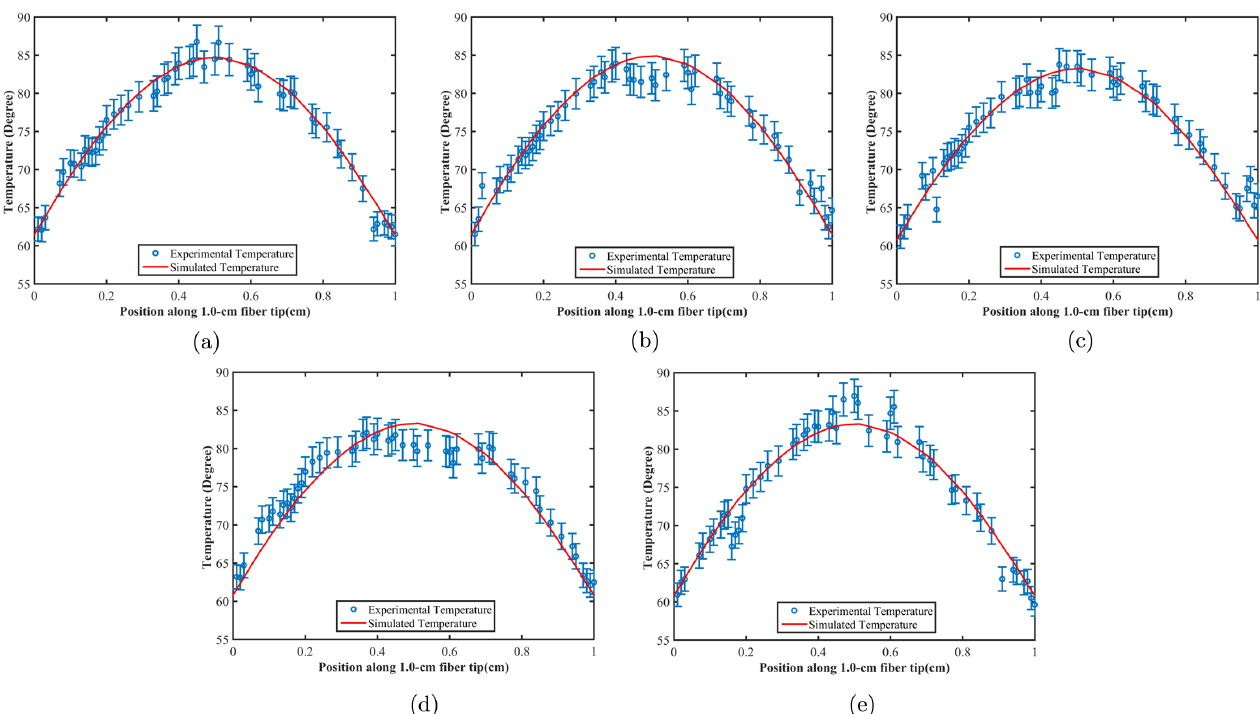
Fig. 5. Temperature distributions along ¯ber tip determined by PA signals (experimental) and computational simulation (the- oretical) with (a) (cid:1) a ¼ 0 : 07 mm (cid:4) 1 and (cid:1) s ¼ 14 : 0mm (cid:4) 1 , (b) (cid:1) a ¼ 0 : 08 mm (cid:4) 1 and (cid:1) s ¼ 13 : 0 mm (cid:4) 1 , (c) (cid:1) a ¼ 0 : 065 mm (cid:4) 1 and (cid:1)